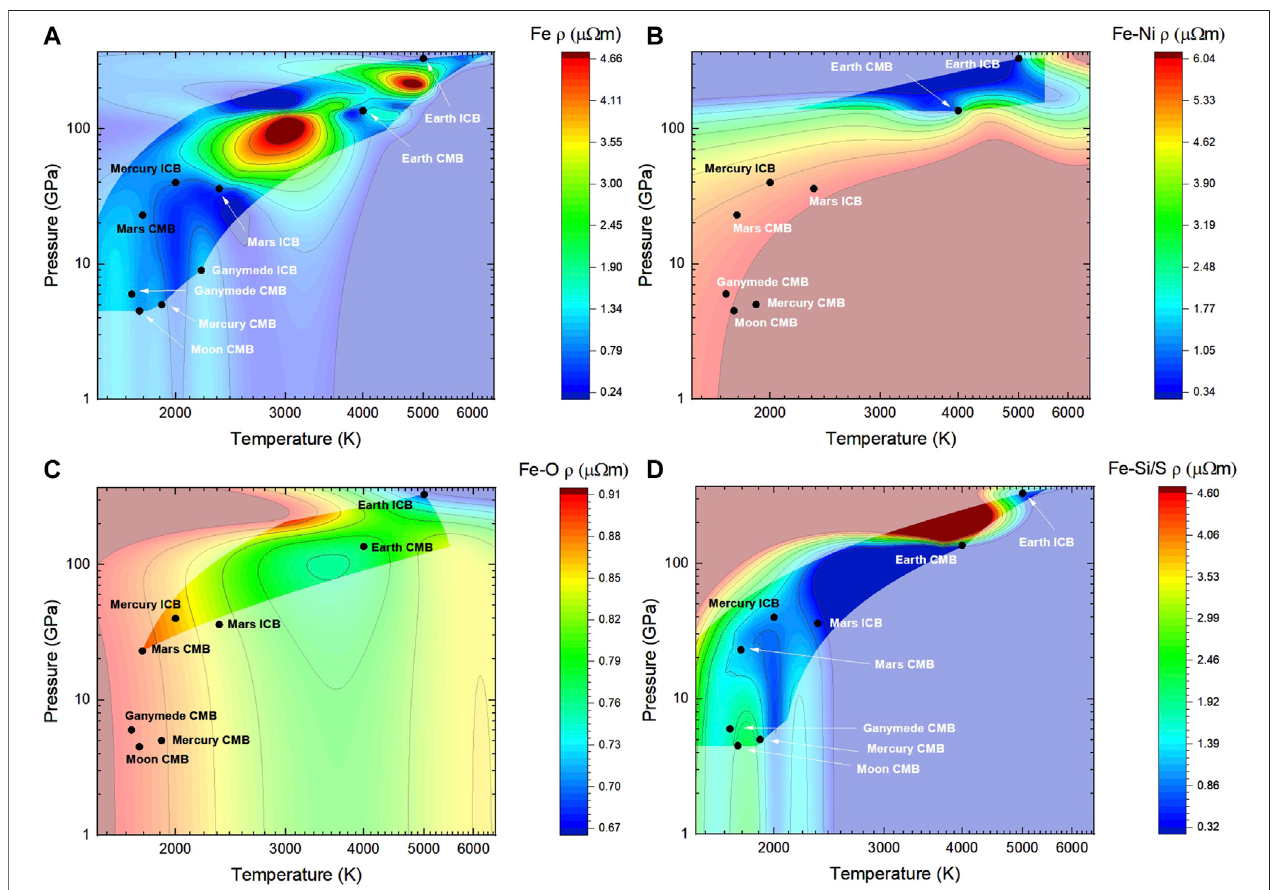
FIGURE7| 3Dvisualizationofthereported ρ with P and T of (A) Fe, (B) Fe-Nialloys, (C) Fe-Oalloys,and (D) Fe-Si/Salloys.Studiesthatdidnotstatetheexact P , T conditionsforEarth ’ sCMBandICBareplacedat4,000 Kand136 GPa,and5,000 Kand330 GPa,respectively.Similarly,thelunarCMBisplacedat1,750 K(whichis the mid- T range of 1,687 – 1,800 K) and 4.5 GPa. Mercury ’ s CMB and ICB are placed at 1,900 K and 5 GPa, and 2,350 K (which is the mid- T range of 2,200 – 2,500 K) and 36 GPa, respectively. The Martian CMB and ICB are placed at 1,770 K and 23 GPa, and 2,000 K and 40 GPa, respectively. Ganymede ’ s CMB is located